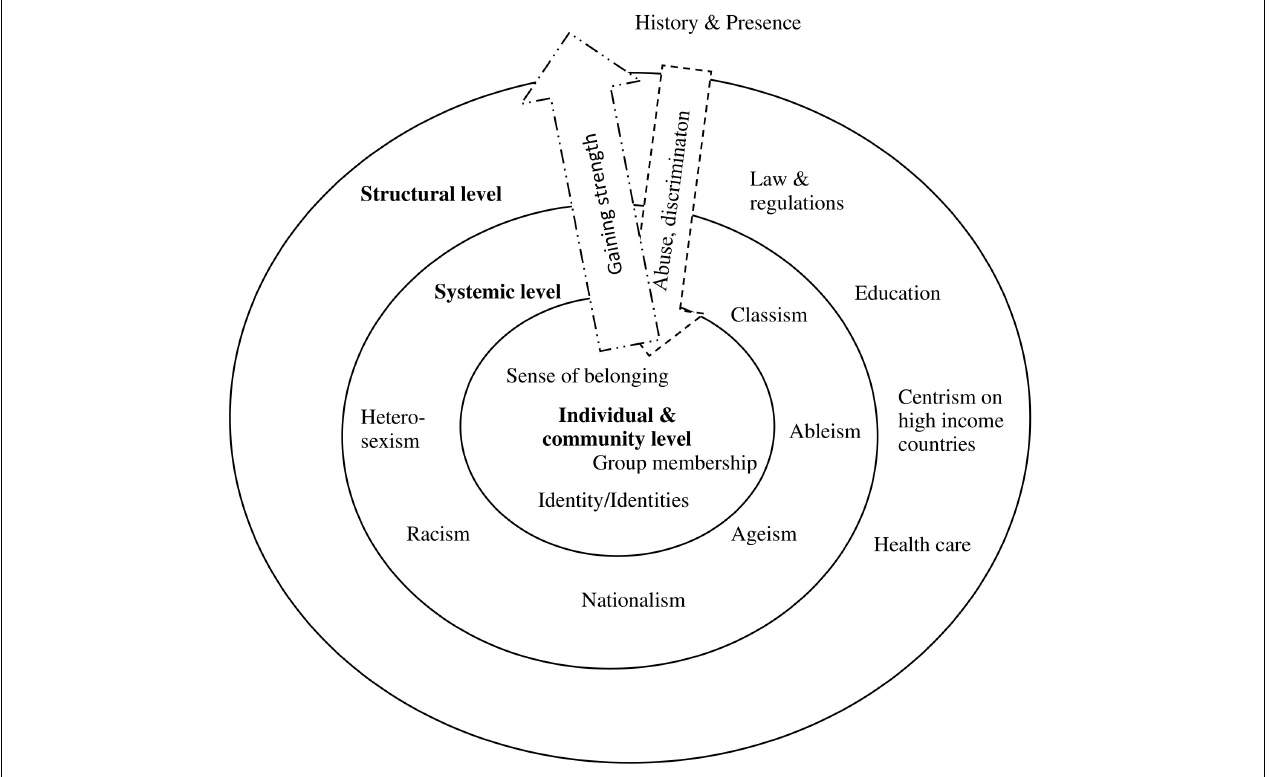
FIGURE 3 | Resilience across